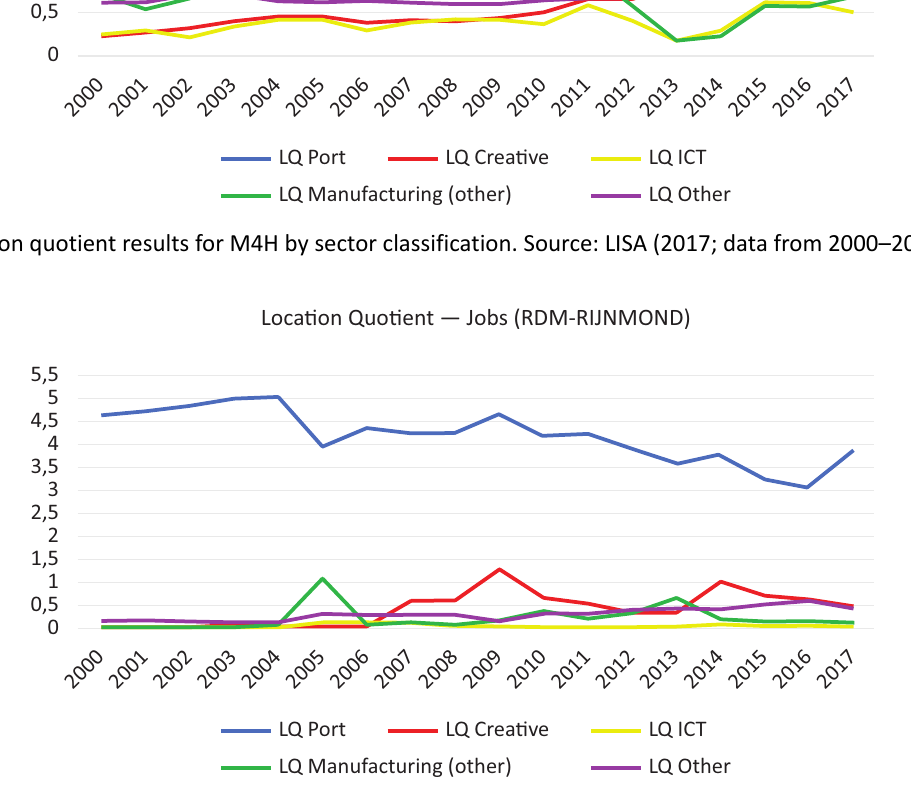
Figure 3. Location quotient results for RDM by sector classification. Source: LISA (2017; data from